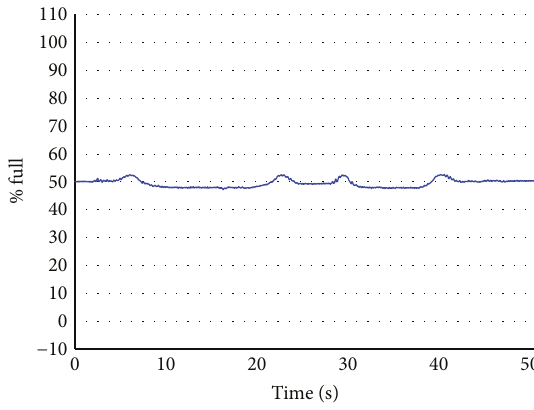
Figure 7: The average of the two tank half values from the end-to- end